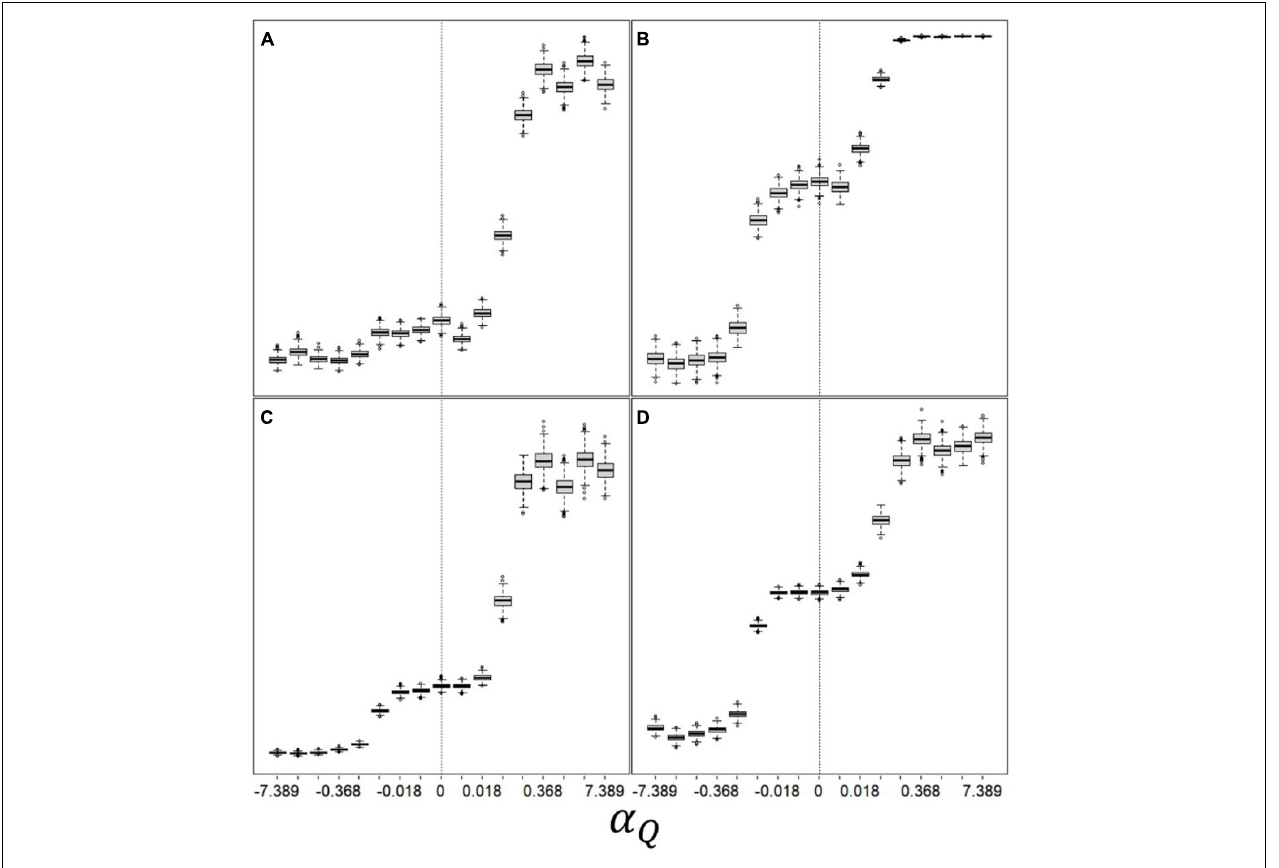
FIGURE 5 | Emerging space-use patterns as function of valence-dependence for patch quality: (A) “movement rate” (% time spent travelling; 9–23), (B) “exploration rate” (% patch departures to new patches; 55–100), (C) home-range size (number of unique patches used during the simulation; 5–24), and (D) mean giving-up density (average number of bites remaining in a patch once departed; 36–80) Q ( t = 0) = b Q = 100; T ( t = 0) = b T = 10; CV ( Q ) = CV ( T ) = 0.5; p travel = 2 t max - 1 ; other parameters and variables were as detailed in Table 1 . α T was kept constant at its optimal value (which is 0 in this specific